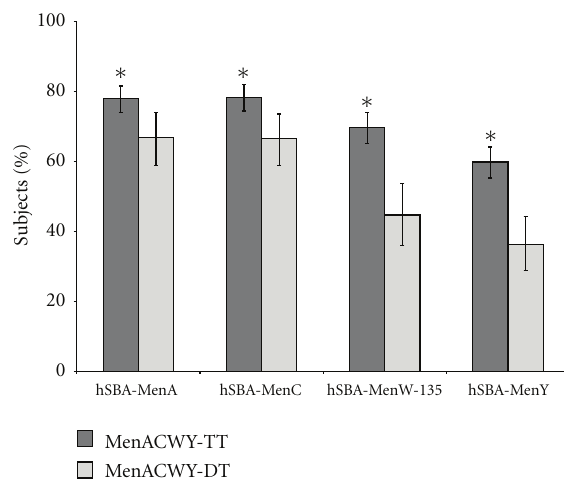
Figure 1: Vaccine response for hSBA antibodies one month after vaccination with MenACWY-TT or with a control vaccine in subjects aged 11–25 years (ATP cohort for immunogenic- ity). (MenACWY-TT: subjects vaccinated with MenACWY-TT, MenACWY-DT: subjects vaccinated with MenACWY-DT, vaccine response defined as (1) for initially seronegative subjects, antibody titres ≥ 1 :16 at one month after vaccination, (2) for initially sero- positive subjects, antibody titres at one month after vaccination ≥ 4- fold the prevaccination antibody titre. Error bars represent the 95% confidence interval. ∗ Statistically significantly higher value in the ACWY-TT group compared to the ACWY-DT group (exploratory analysis). Results of this figure are currently in publication